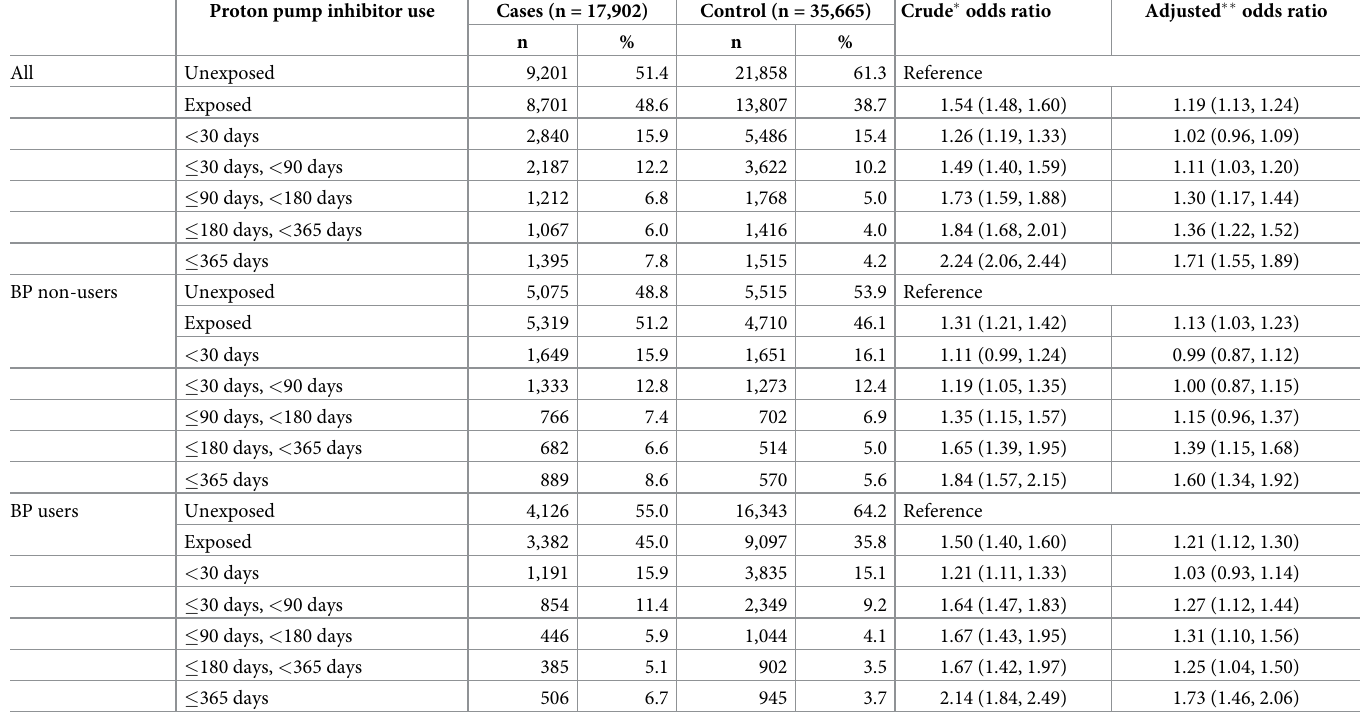
Table 3. Osteoporotic fracture risk among patients exposed to proton pump inhibitor within 1 year prior to fracture date. Proton pump inhibitor